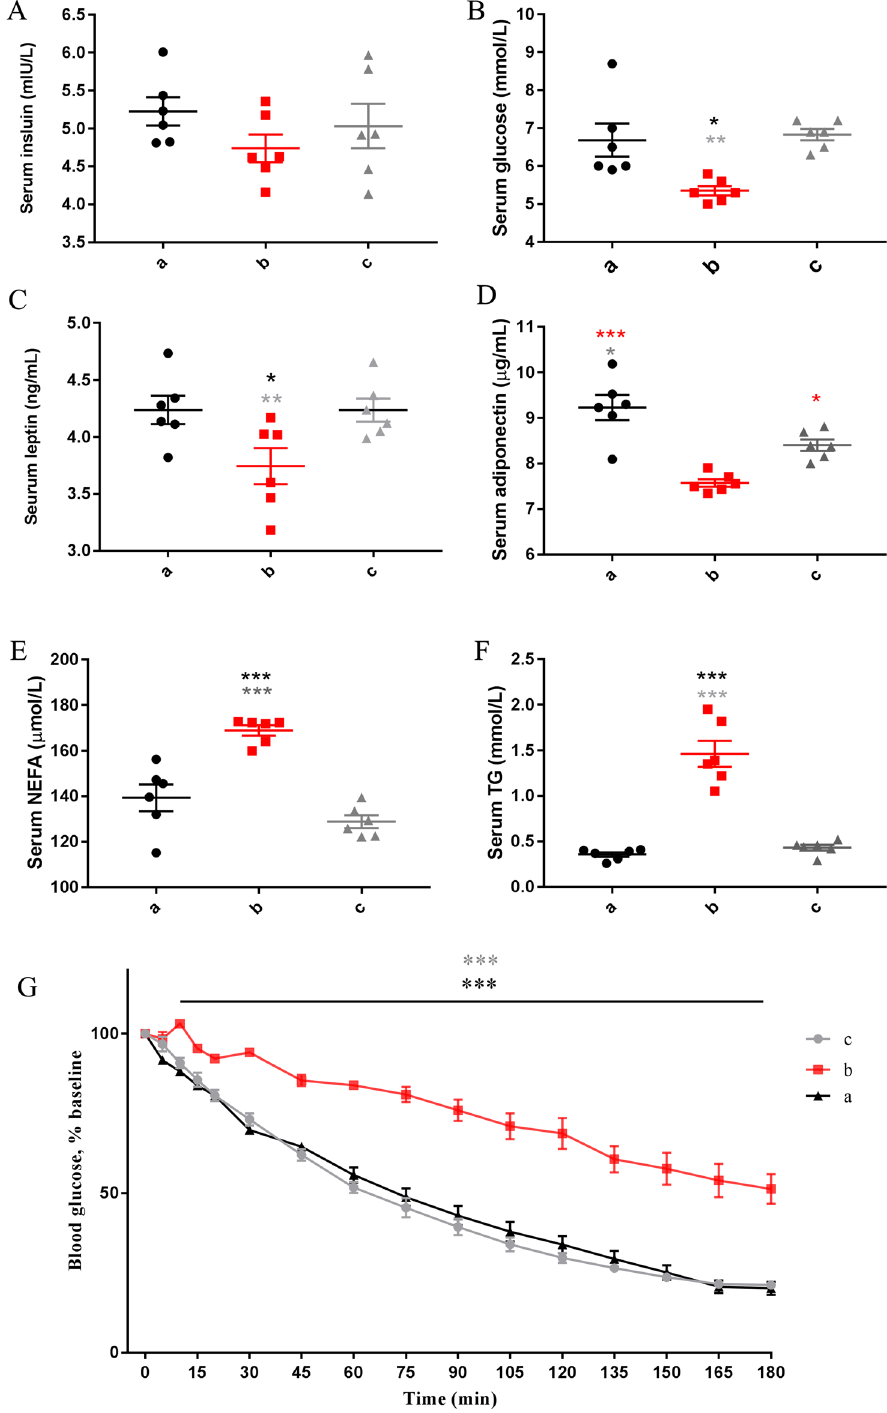
Figure 3. ( A ) Serum insulin levels. ( B ) Serum glucose levels. ( C ) Serum leptin levels. ( D ) Serum adiponectin levels. ( E ) Serum nonesterified fatty acid (NEFA) levels. ( F ) Serum triglyceride (TG) levels. Statistical analysis was performed by one-way ANOVA with Tukey’s multiple comparison post-test (* p < 0.05, ** p < 0.01, *** p < 0.001). ( G ) Insulin tolerance tests (ITTs). Statistical analyses were performed using multiple unpaired t tests (* p < 0.05, ** p < 0.01, *** p < 0.001). a: Feeding period, b: fasting period, c: recovery feeding period. Black, red and grey asterisks indicate significant differences compared to a, b and c, respectively. All error bars represent ±